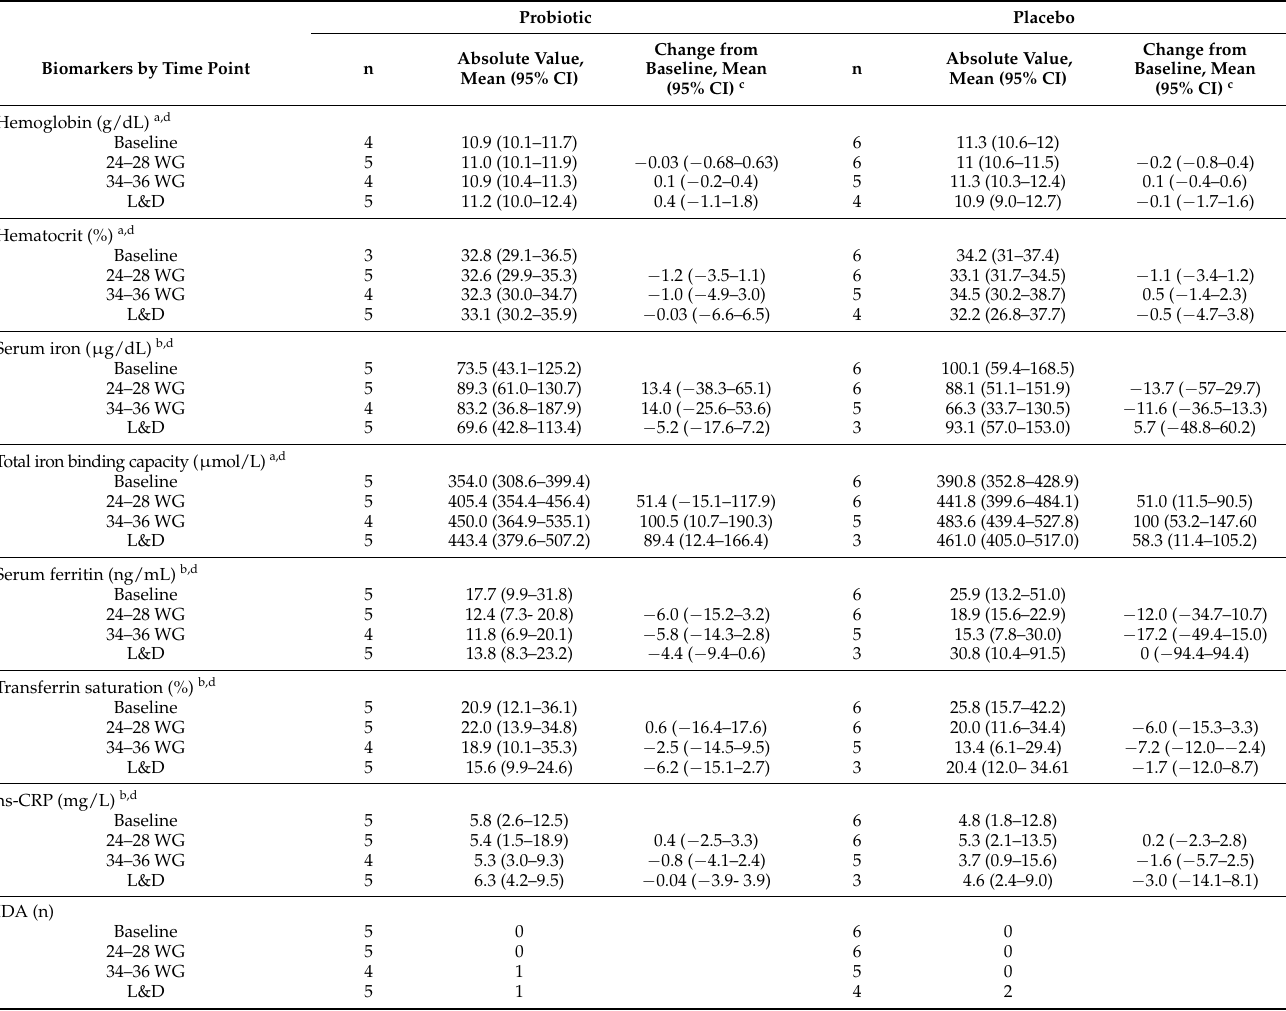
Table 6. Iron status biomarkers for completers with ≥ 80% adherence by randomization group at each time point and mean change from baseline to 24–28 weeks, 34–36 weeks, and labor &